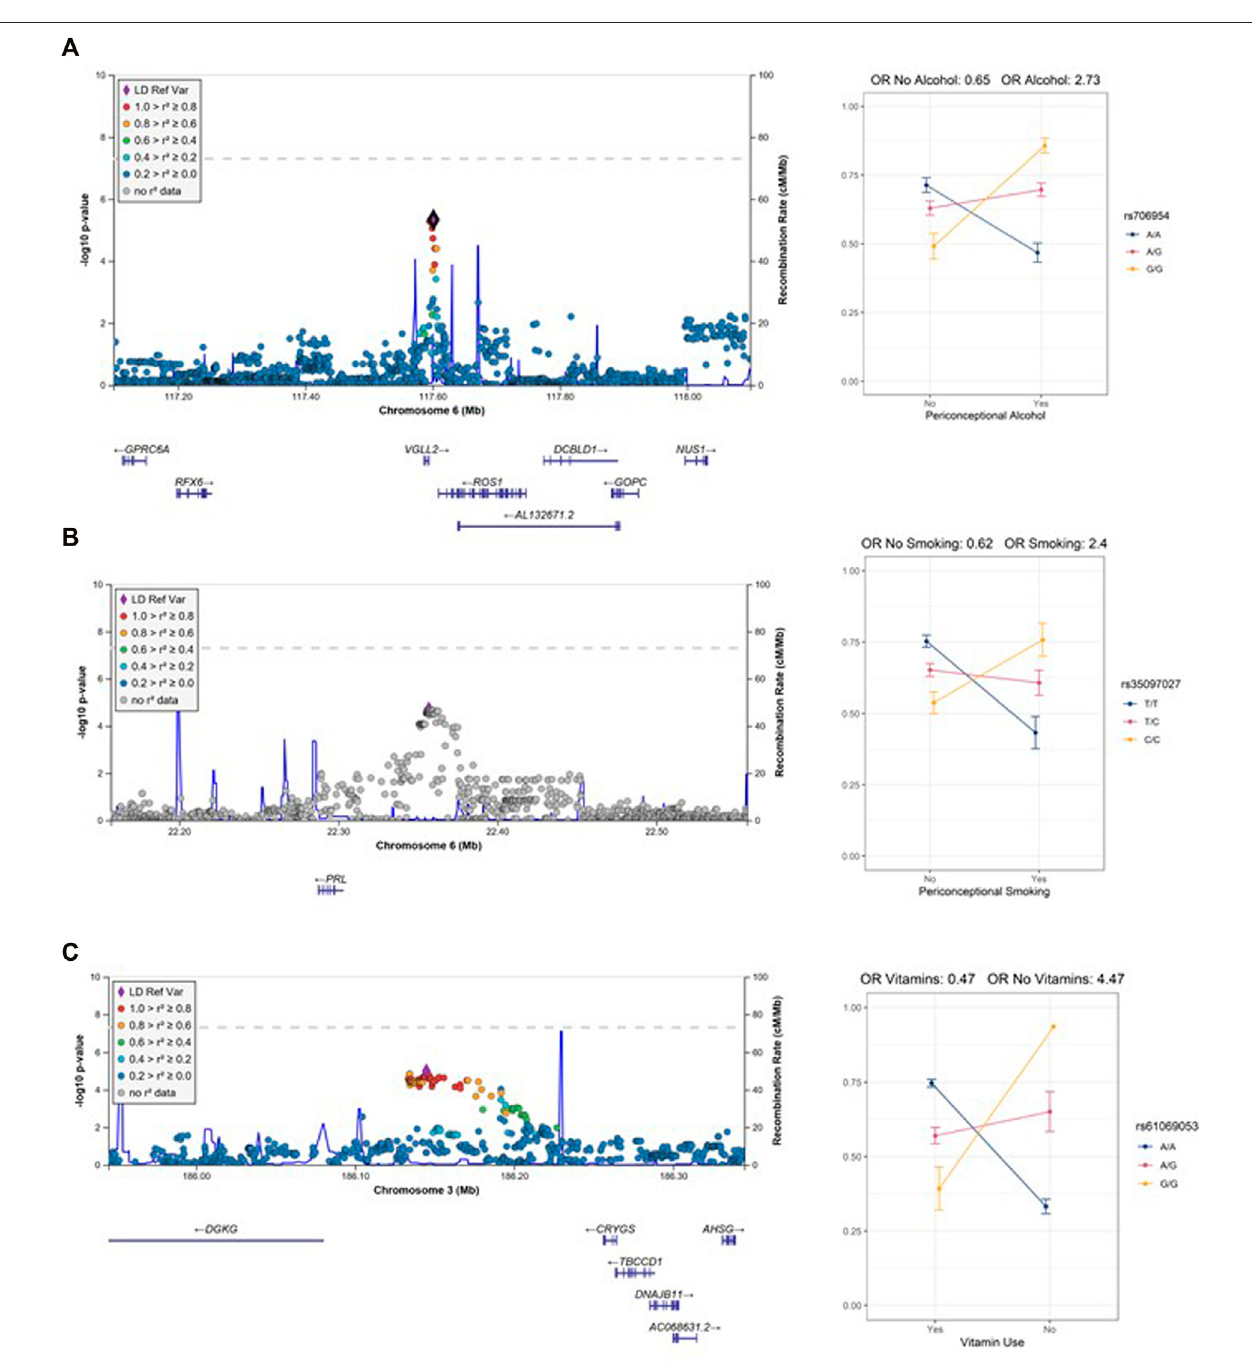
FIGURE 2 | Regional association plots of the GE test with interaction plots (A) 6q22 (rs706954) interaction with alcohol use. (B) 6p22.3 (rs35097027) interaction with smoking. (C) 3q27.3 (rs61069053) with vitamin use. Note, only one individual is homozygous for the G allele in the no vitamin use stratum.